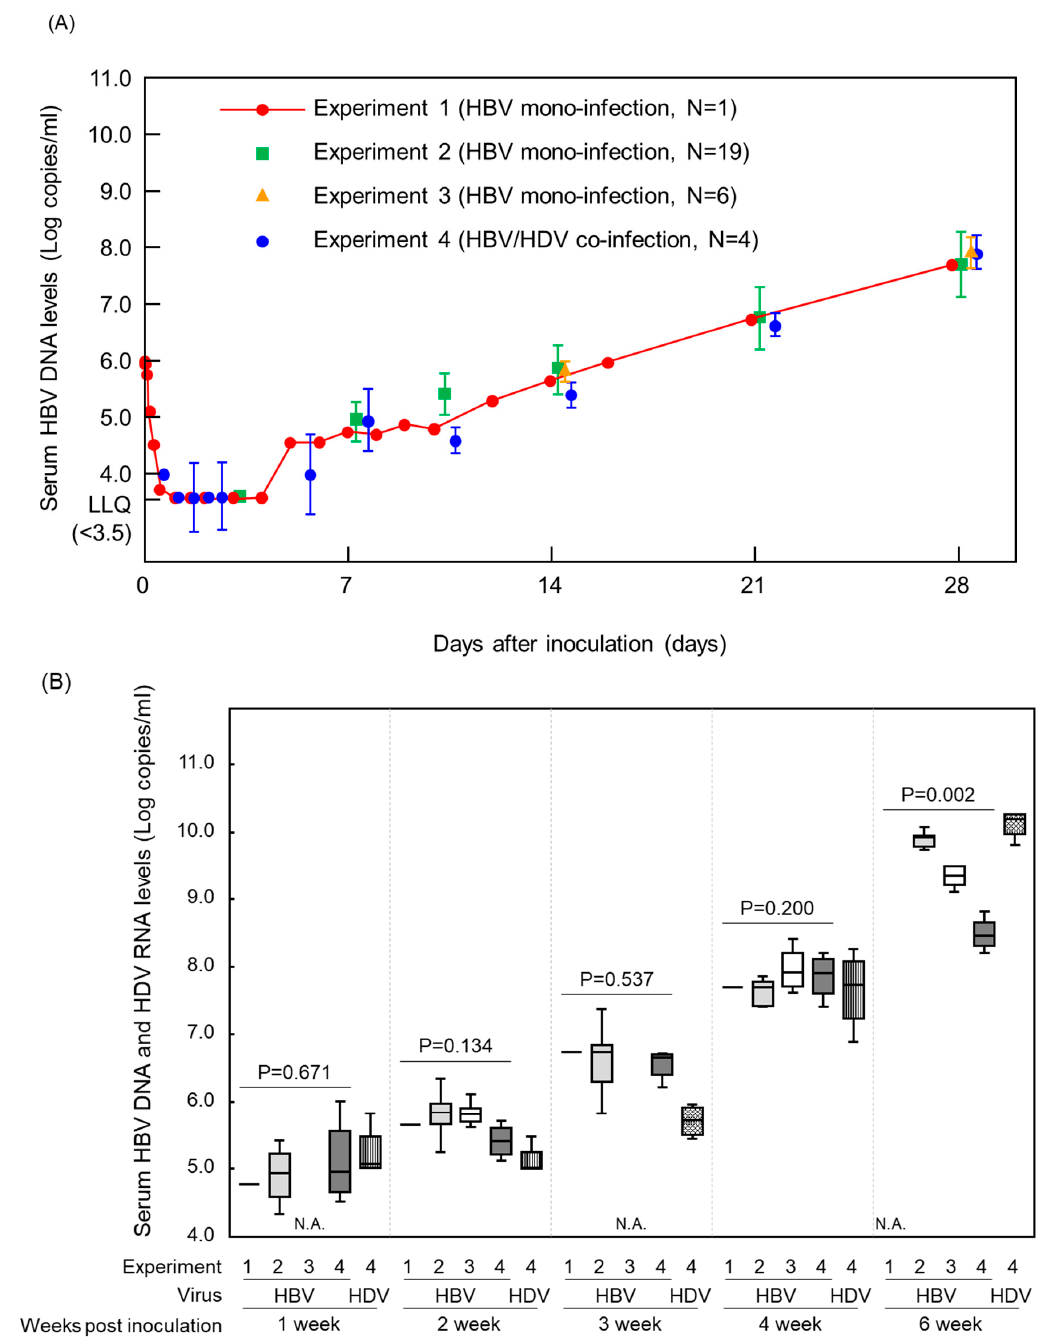
Figure 1. Comparison of HBV infection initiation kinetics in human hepatocyte chimeric mice. ( A ) Average hepatitis B virus (HBV) load with standard deviation from days 0–28 post inoculation (p.i.) in each experiment. ( B ) Comparison of serum HBV DNA levels between each experiment at indicated time points. Statistical analyses of HBV DNA levels were performed between HBV